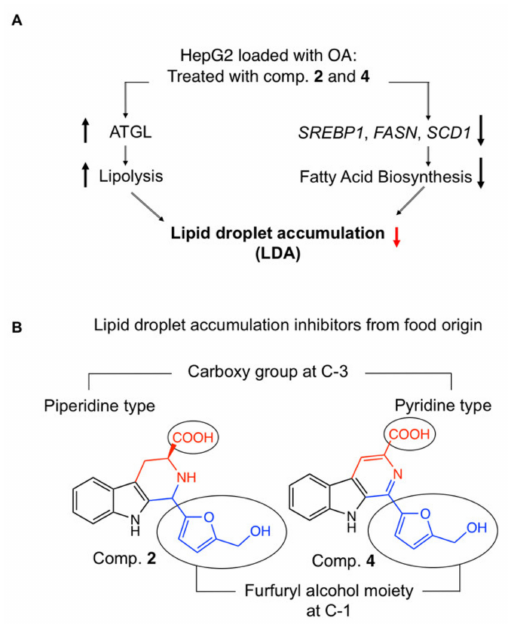
Figure 7. ( A ) Proposed LDAI activity pathway of compounds 2 and 4 in HepG2 cells; ( B ) Chemical structure features of food-derived LDA inhibitors 2 and 4 important for LDAI